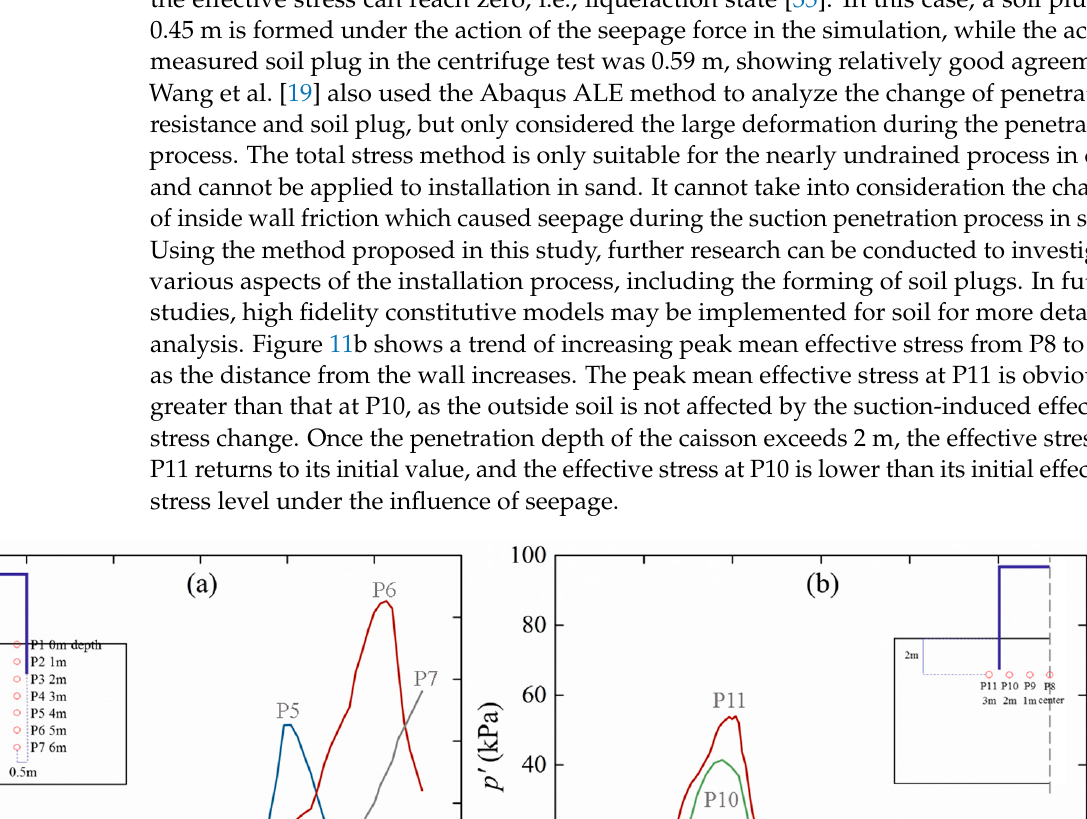
Figure 12. Shear modulus distribution at typical points within the soil at the end of jacked and suction penetration: ( a ) Points P1 to P7 at 0 m to 6 m depths 0.5 m inside the caisson wall; ( b ) Points P8 to P11 at 0 m to 3 m horizontal distances from the center of the caisson at 2 m depth. Strictly speaking, the permeability coefficient should be 1×10 − 2 m/s; to speed up cal- culation, the permeability coefficient is artificially reduced and it is demonstrated that the reduction of the permeability coefficient has little effect on penetration resistance when the permeability coefficient exceeds 1×10 − 4 m/s. As shown in Figure 13, the penetration resistance of the suction caisson at the final penetration depth of 5.55 m increases with increasing permeability, but gradually stabilizes after the permeability coefficient in- creases to 8×10 − 5 m/s. This is because when the permeability is great enough, diffusion of excess pore pressure is fast enough in the soil that a further increase in permeability only affects the amount of seepage flow but not soil response. At the simulation permeability